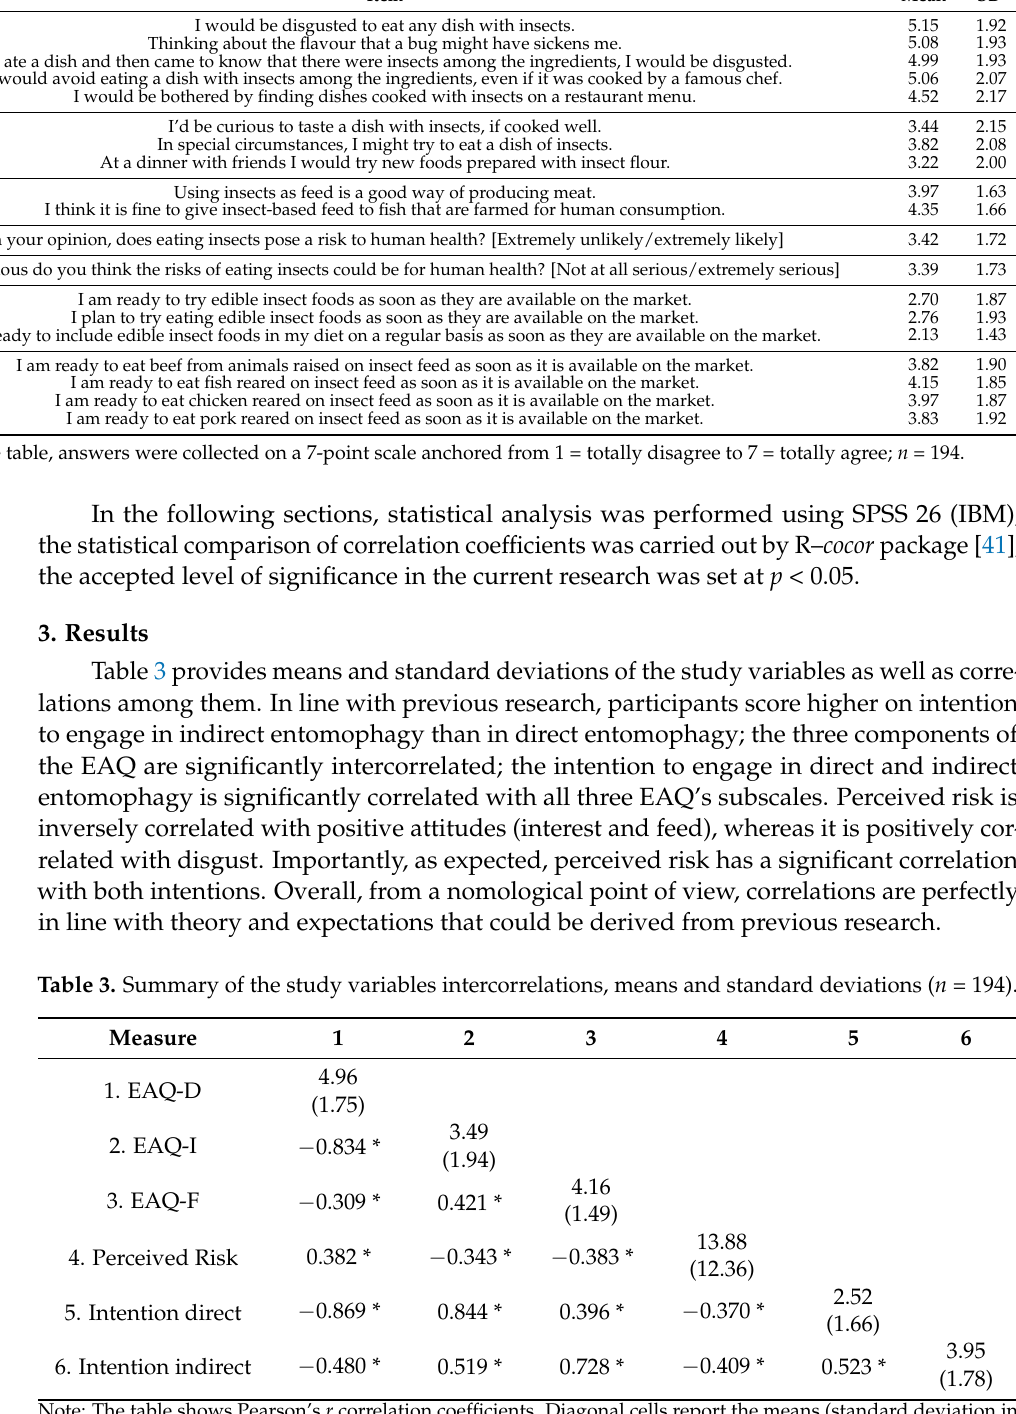
Table 2. Mean values and standard deviations of the items used in the study questionnaire. Item